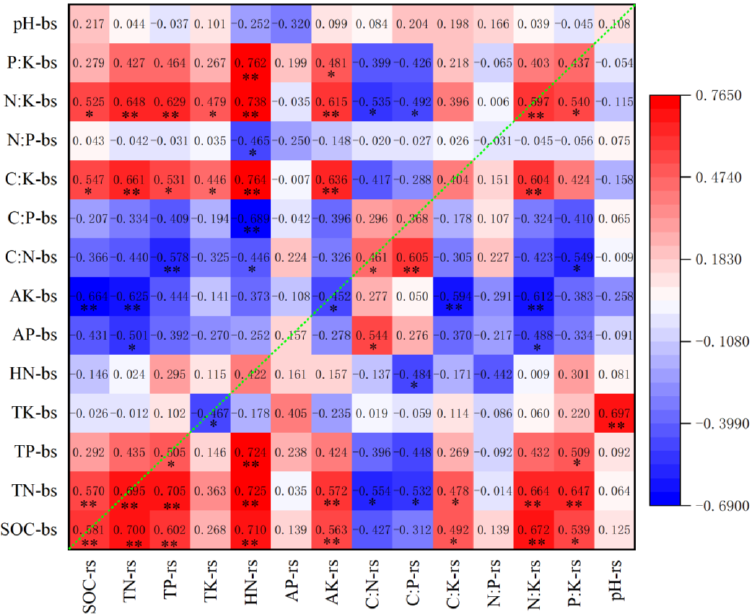
Figure 9. Pearson’s correlation heatmap of bulk soil and rhizosphere soil: * Significant at p < 0.05; ** significant at p < 0.01; rs, rhizosphere soil; bs, bulk soil.